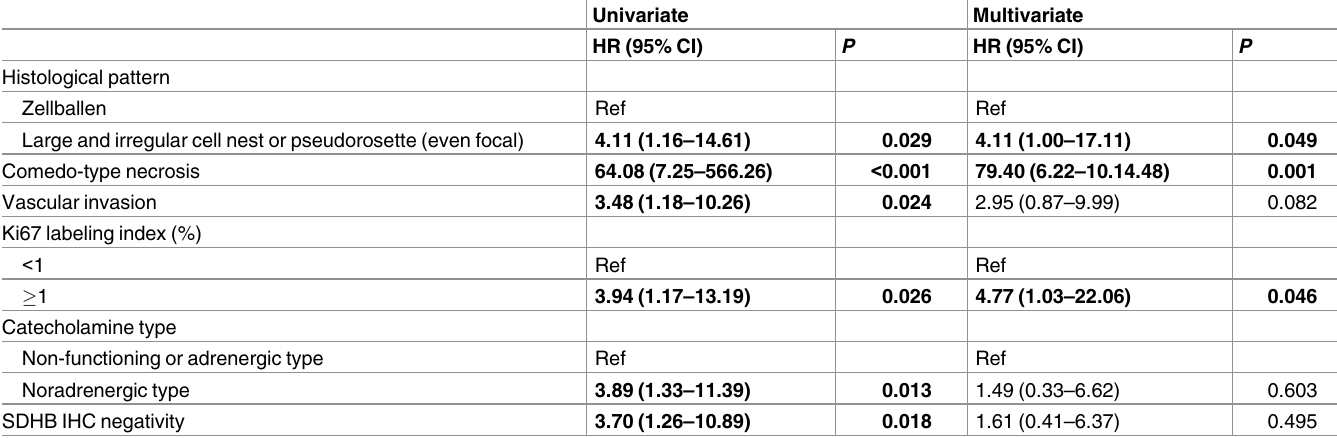
Table 5. Association of the individual parameters of the M-GAPP at the initial operation with occurrence of metastasis.